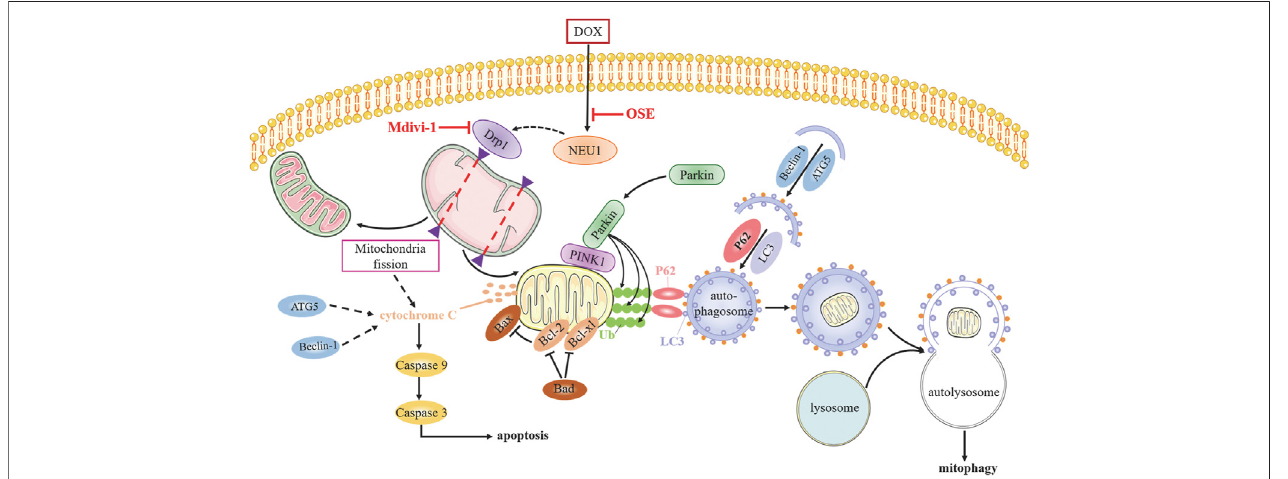
FIGURE 8 | The potential molecular mechanisms of OSE against DOX-induced cardiotoxicity.